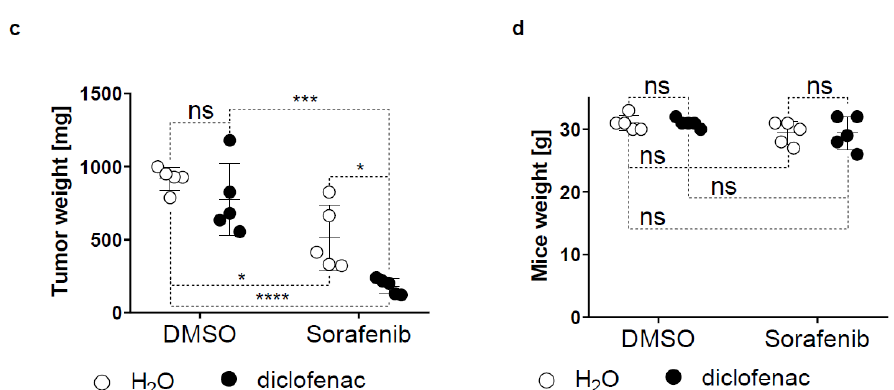
Figure 5. Anticancer efficacy of sorafenib and diclofenac in Huh-7 tumor xenografts. ( a ) Growth curves of Huh-7 tumor xenografts treated with the vehicle, diclofenac (30 µg/g mice/day p.o), sorafenib (15 µg/g mice/day p.o) or sorafenib and diclofenac (5 mice per group). ( b ) Tumor volumes measured ex vivo following sacrifice of the mice. ( c ) Tumor weights were determined following sacrifice of the mice. ( d ) Mice weights measured before sacrifice. p value: * < 0.05, ** < 0.01, *** < 0.001, **** < 0.0001, ns: nonsignificant, two- way ANOVA with Sidak’s multiple comparisons test.